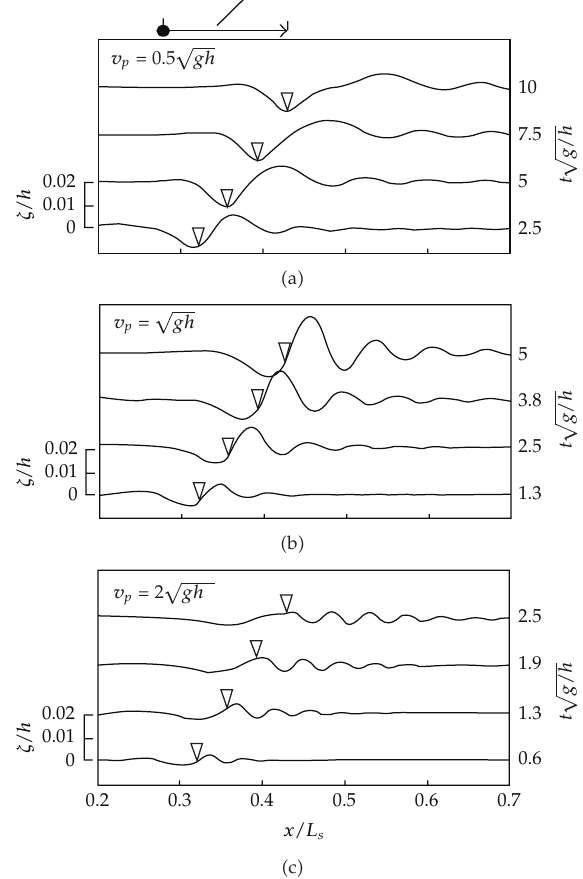
Figure 8: Time variation of surface profiles due to the point load moving on the floating thin plate, where ζ is surface displacement. The length of thin plate, L s , and moving distance of point load, L p , are 35.0m and 5.0m, respectively; B s (cid:7) 500.0Nm 2 . The number of terms for velocity potential, N , is equal to two. The mark (cid:2) indicates the position of moving point